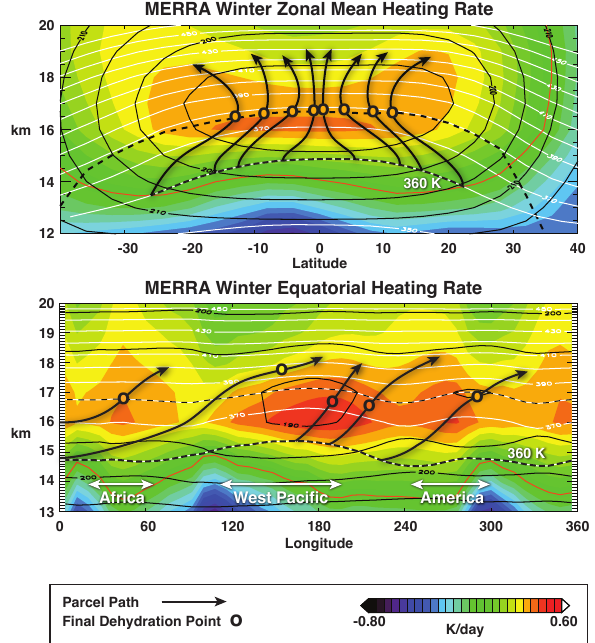
Fig. 10. Diagram of the dehydration process. Parcel paths for parcels entering the stratosphere are shown as black arrows. The color background shows the heating rate (Kday − 1 ) from MERRA; black contours are temperature (K), and white contours are poten- tial temperature (K). Thin dashed black line is the tropopause, thick dashed black line is 360K surface – roughly the level where parcels in our model are initialized. Top figure is zonal mean cross section where the air parcels moving upward concentrate latitudinally at the tropopause before rising into the stratosphere. Lower figure shows parcel paths vs. longitude along the equator. Small circles in both figures indicate the final dehydration points showing that the dehy- dration can take place at different altitudes. See text for